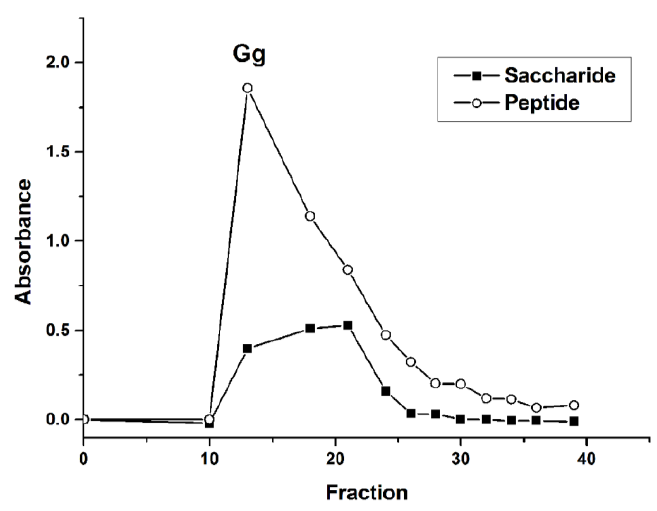
Figure 1. Sephadex G-15 elution profile. Saccharide: absorbance at 490 nm from the phenol‐sulfuric acid assay. Peptide: absorbance at 280 nm.